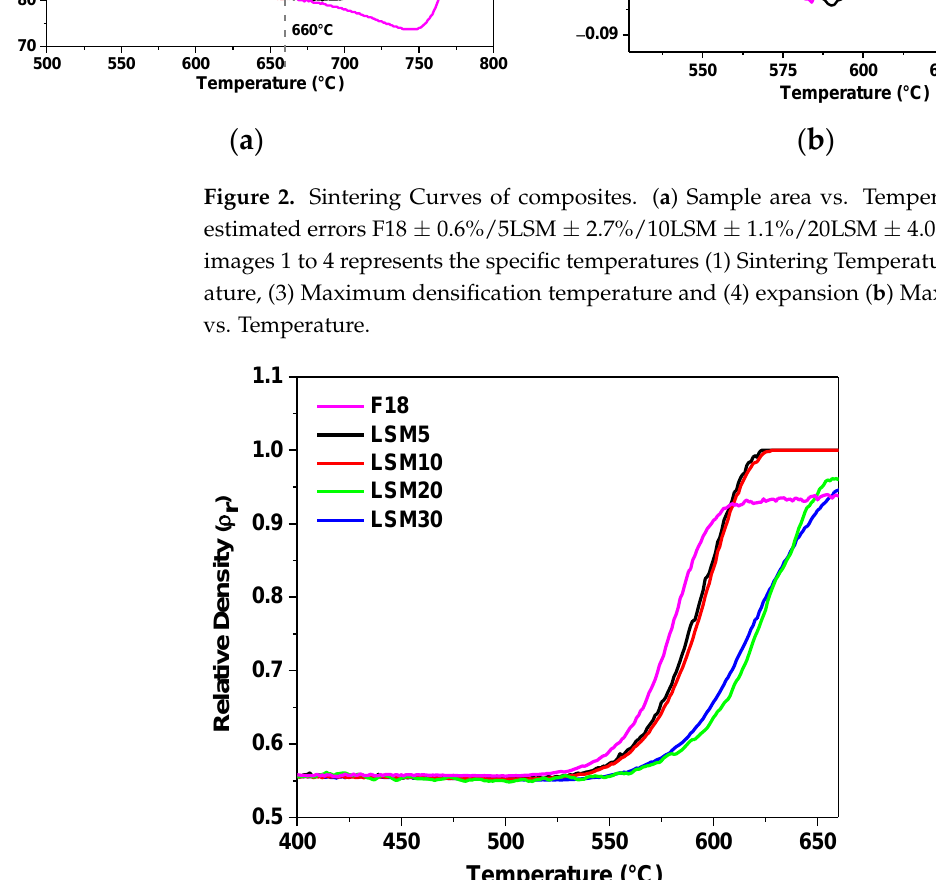
Figure 3. Relative density as a function of temperature of composites with a maximum temperature of 660 °C and heating rate of 10 °C/min.